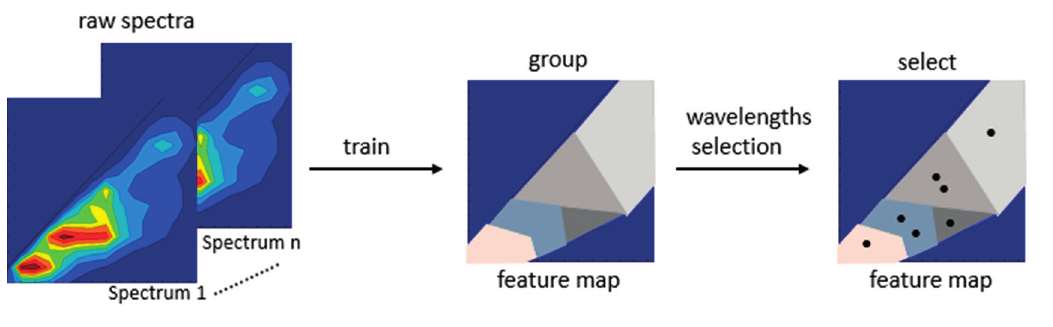
Figure 5. Illustrated overview using SOM for fluorescence